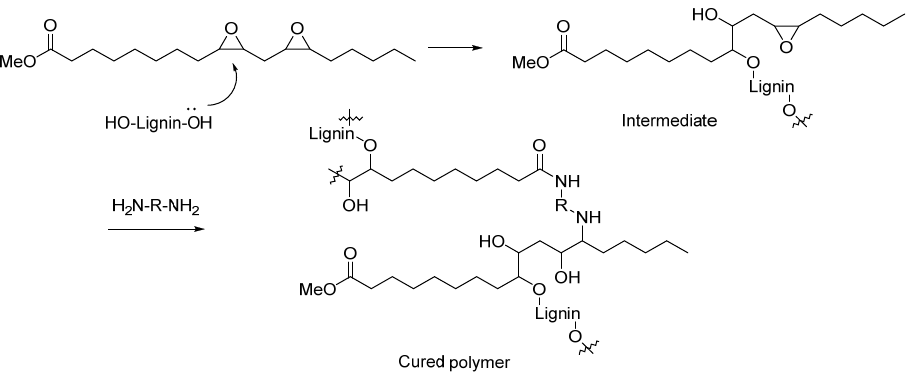
Scheme 2. Proposed mechanism of the curing of the epoxy resins.